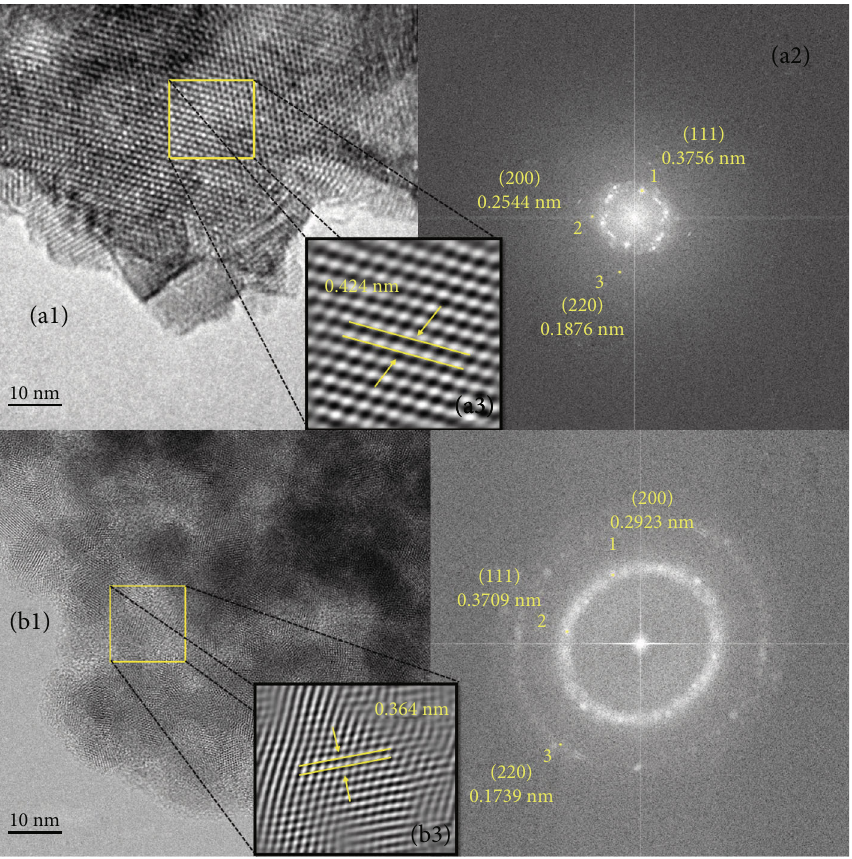
Figure 4: High-resolution transmission electron microscopy (HRTEM) patterns of pure CdS. (a1) Synthetized by coprecipitation and (b1) synthesis assisted with sonochemistry, the growth patterns (randomly oriented polycrystalline material); (a2) and (b2) the selected portion shows the Fourier transformed from (a1) and (b1); and (a3) and (b3) show the interplanar spacing between